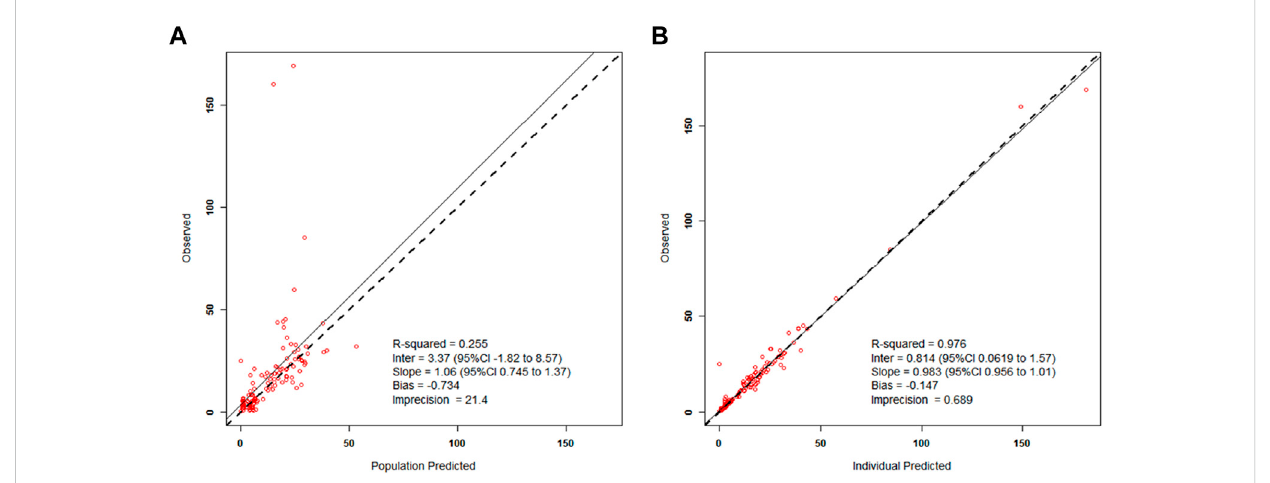
FIGURE 2 Leftside (A) — Scatterplotofthepredicted – found relationships basedon themean population parametersfor all patients;Right side (B) — Scatterplot of the predicted – found relationships based on calculating each subject ’ s own mean value of his/her Bayesian posterior joint parameter